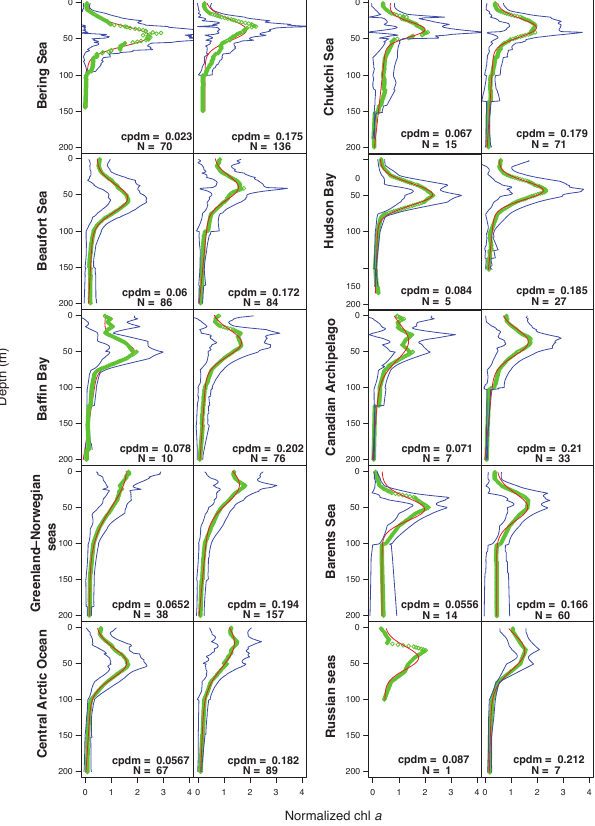
Fig. 7. Average dimensionless chlorophyll a (Chl a) profiles (green lines) obtained for each category (C1–C2) at deep ( > 50m) stations of each sub-Arctic and Arctic sea during the post-bloom period. Red and blue lines represent the parameterized vertical Chl a pro- files and standard deviation, respectively. N and cpdm represent the number of stations and the averaged Chl a surf value, respectively.